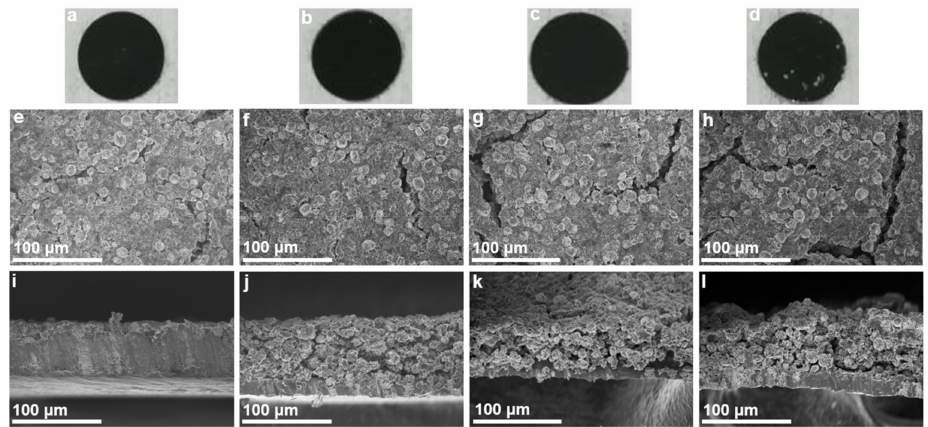
Figure 4. ( a – d ) Optical images, and ( e – h ) surficial and ( i – l ) cross-sectional SEM images of the ( a , e , i ) PEO0, ( b , f , j ) PEO20, ( c , g , k ) PEO50, and ( d , h , l ) PEO100